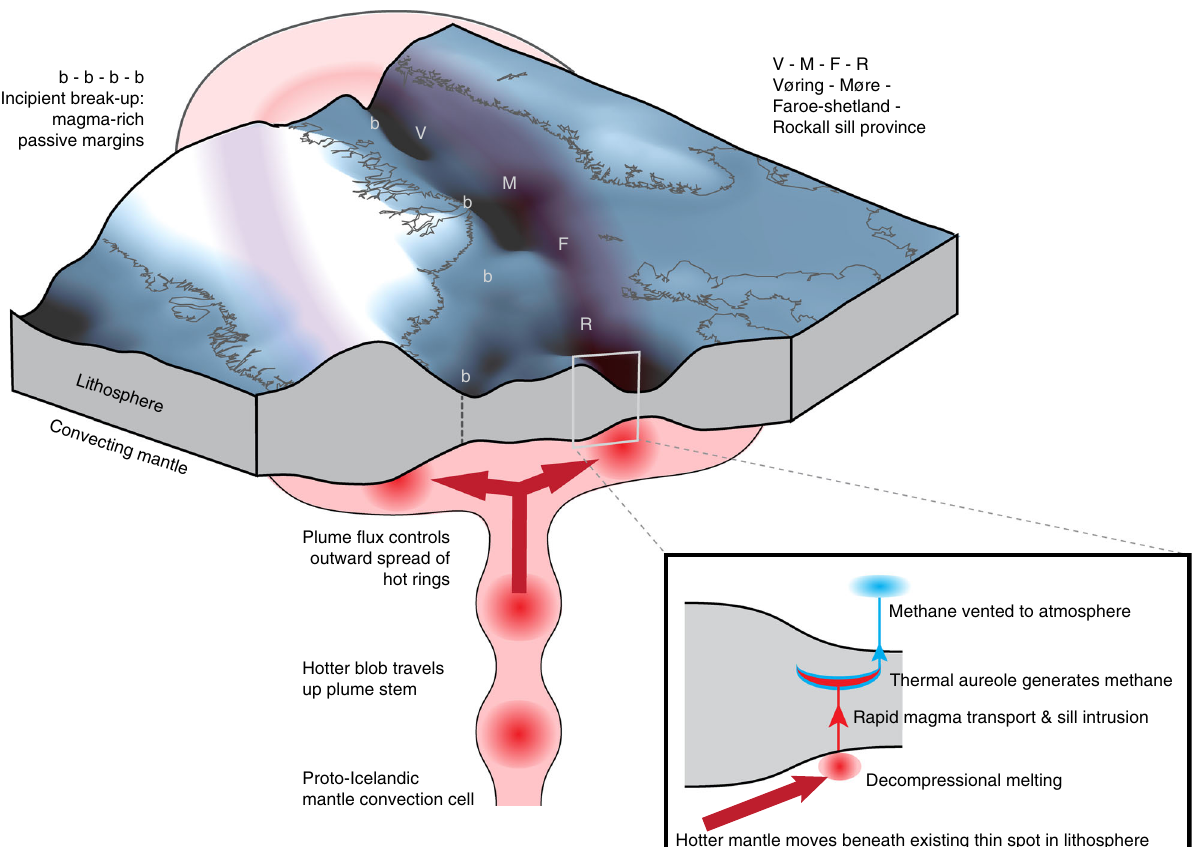
Fig. 1 New framework for determining greenhouse gas emissions from the North Atlantic Igneous Province. Initiation of the Icelandic mantle convection cell occurred during early to middle Paleocene time, accompanied by volumetrically minor igneous activity. By late Paleocene time, a mantle plume head comprising anomalously hot mantle lay beneath the lithosphere of NW Europe and Greenland, fed by a conduit beneath eastern Greenland. Flow within all upper mantle convection cells is unsteady, or pulsing. Pulses are patches of mantle with particularly high temperature anomalies that travel up the plume conduit and spread outwards within the plume head as rings. The hottest of these pulses travelled up the plume conduit in latest Paleocene time and spread through the plume head in earliest Eocene time. When this thermal pulse travelled beneath thin lithosphere, the reduction in depth led to pressure- release partial melting. The rate of magma generation depended on the mantle plume fl ux. Most thin-spot melting occurred beneath the chain of deep- water sedimentary basins comprising the Rockall, Faroe-Shetland, Møre and Vøring Basins (labelled R, F, M and V, respectively), which had formed by rifting during mid Cretaceous time. Basaltic magma generated at the base of the lithosphere separated rapidly from the mantle source and travelled rapidly upwards. Much of this magma stalled within the crust as roughly horizontal, sheet-like intrusions called sills, known collectively as the NAIP sill province. The sills heated the surrounding sedimentary rock and converted trace amounts of organic carbon to thermogenic methane. Heat from the sills also boiled the pore fl uid within the host rock, which fractured the rock and created hydrothermal vents. Pore-water convection carried the methane to the ocean and atmosphere. Additional carbon emissions comprising predominantly magmatic carbon dioxide are associated with break-up between Europe and Greenland to form the NAIP magma-rich passive margins (labelled b-b-b-b). These emissions likely have lower fl ux in comparison with peak thermogenic methane emissions from the NAIP sill province. Thus, mantle plume fl ux is the primary control on both magma generation rate and also thermogenic methane emissions rate associated with the NAIP sill cumulative mass of carbon generated by thermal maturation re fl ectance as a proxy for gas generation as in previous studies of the PETM-NAIP sills link 25 . We used a standard oil-industry kinetic model for gas generation that has been calibrated against both laboratory and geological datasets, which bracket the heating rates generated by shallow igneous sills 31 (Supplementary Table 1). Methane generation involves three reaction pathways: refractory (gas-prone) kerogen matures to produce methane; labile (oil-prone) kerogen matures to produce mostly oil and some methane; and oil cracks to produce methane. Vitrinite tables to estimate the parameter set ( M therm , τ decay , p ) required to re fl ectance reactions can be tracked using the same scheme 32 , and all our model results match a compilation of vitrinite reaction calculate carbon emissions over time from a set of sill dimensions aureole data 25 . dimensions are: A , surface area; S , maximum thickness; β , a dimensionless parameter to describe how thickness varies; and Z , emissions fl ux as a function of time, q therm ( t ), and also the intrusion depth. The host-rock characteristics are: w CH4 , the